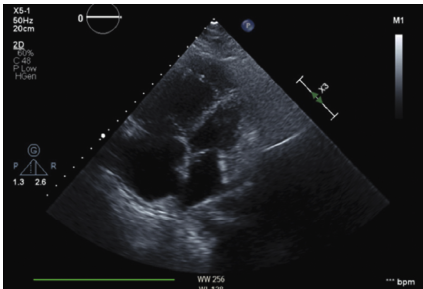
Figure 1: Echodcardioraphy apical 4 chamber view showing right atrial and right ventricular dilation.